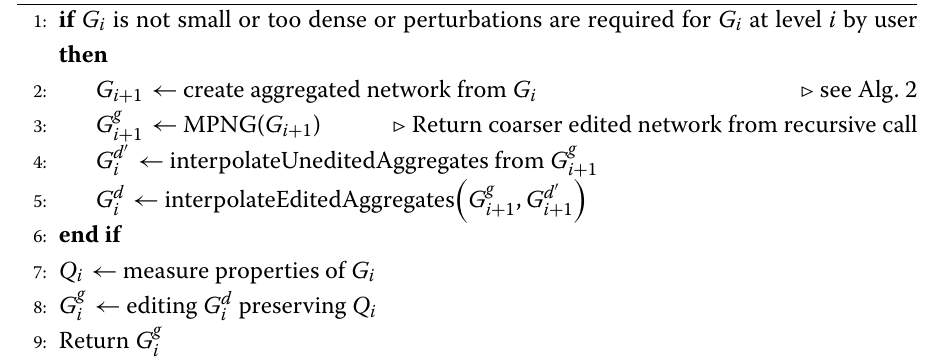
Algorithm 1 Multiscale Planar Network Generator MPNG( G i